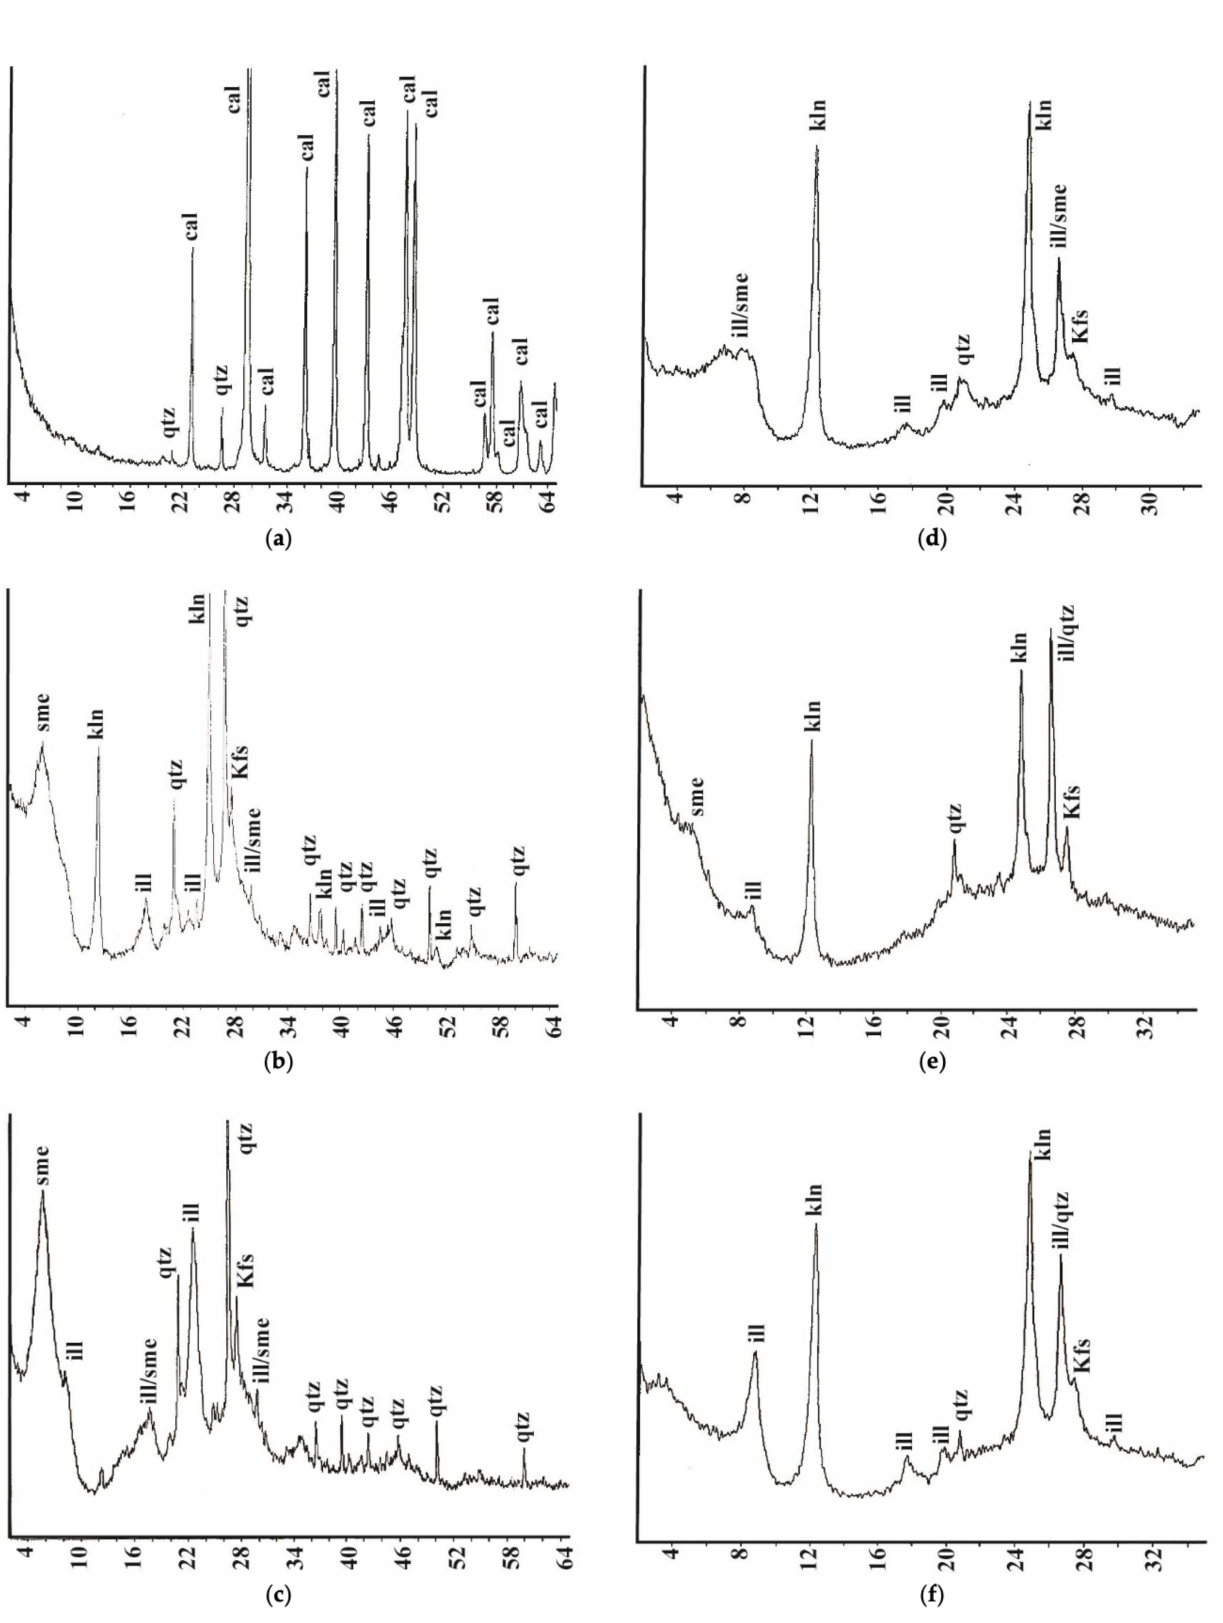
Figure 9. XRD trace patterns of 2Theta ( o ) (x-axis) versus intensity (a.u.) (y-axis): ( a ) whole rock for samples Q1_1 to Q1_16; ( b ) insoluble residue for samples Q1_1 to Q1_10; ( c ) insoluble residue for samples Q1_11 to Q1_16; and clay fraction for selected samples Q1_2 and Q1_4, ( d ) air-dried; ( e ) glycolated; ( f )